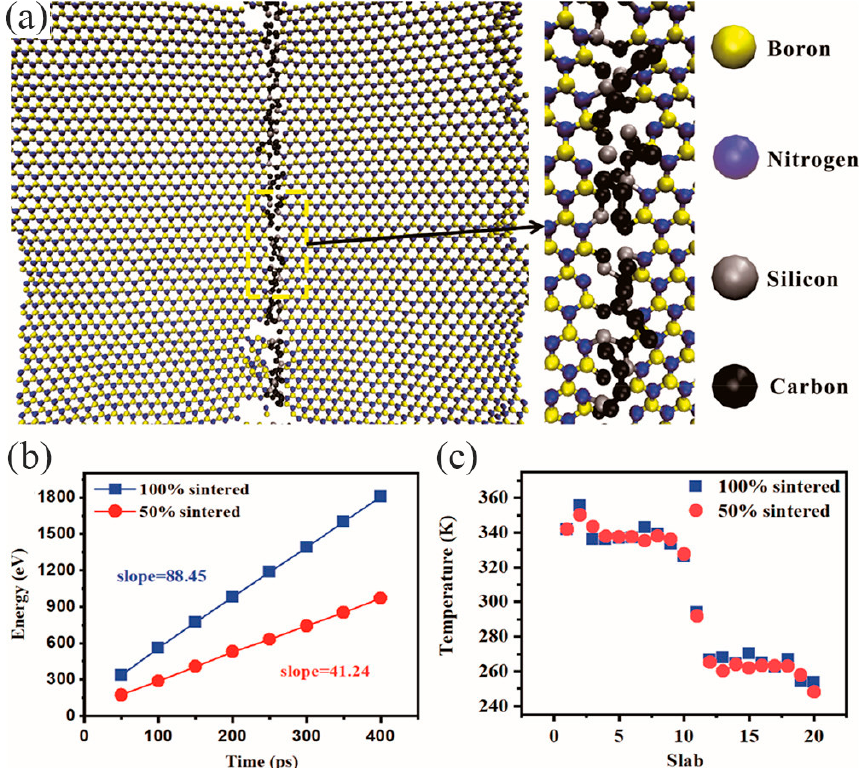
Figure 23. Molecular dynamics (MD) simulations of the interfacial thermal resistance at BN-SiC junction. ( a ) Schematic of sintered h-BN/SiC junction. ( b ) Energy injecting into the heat sink varies with time. ( c ) Temperature distribution along the x direction (reproduced with permission from [191]).